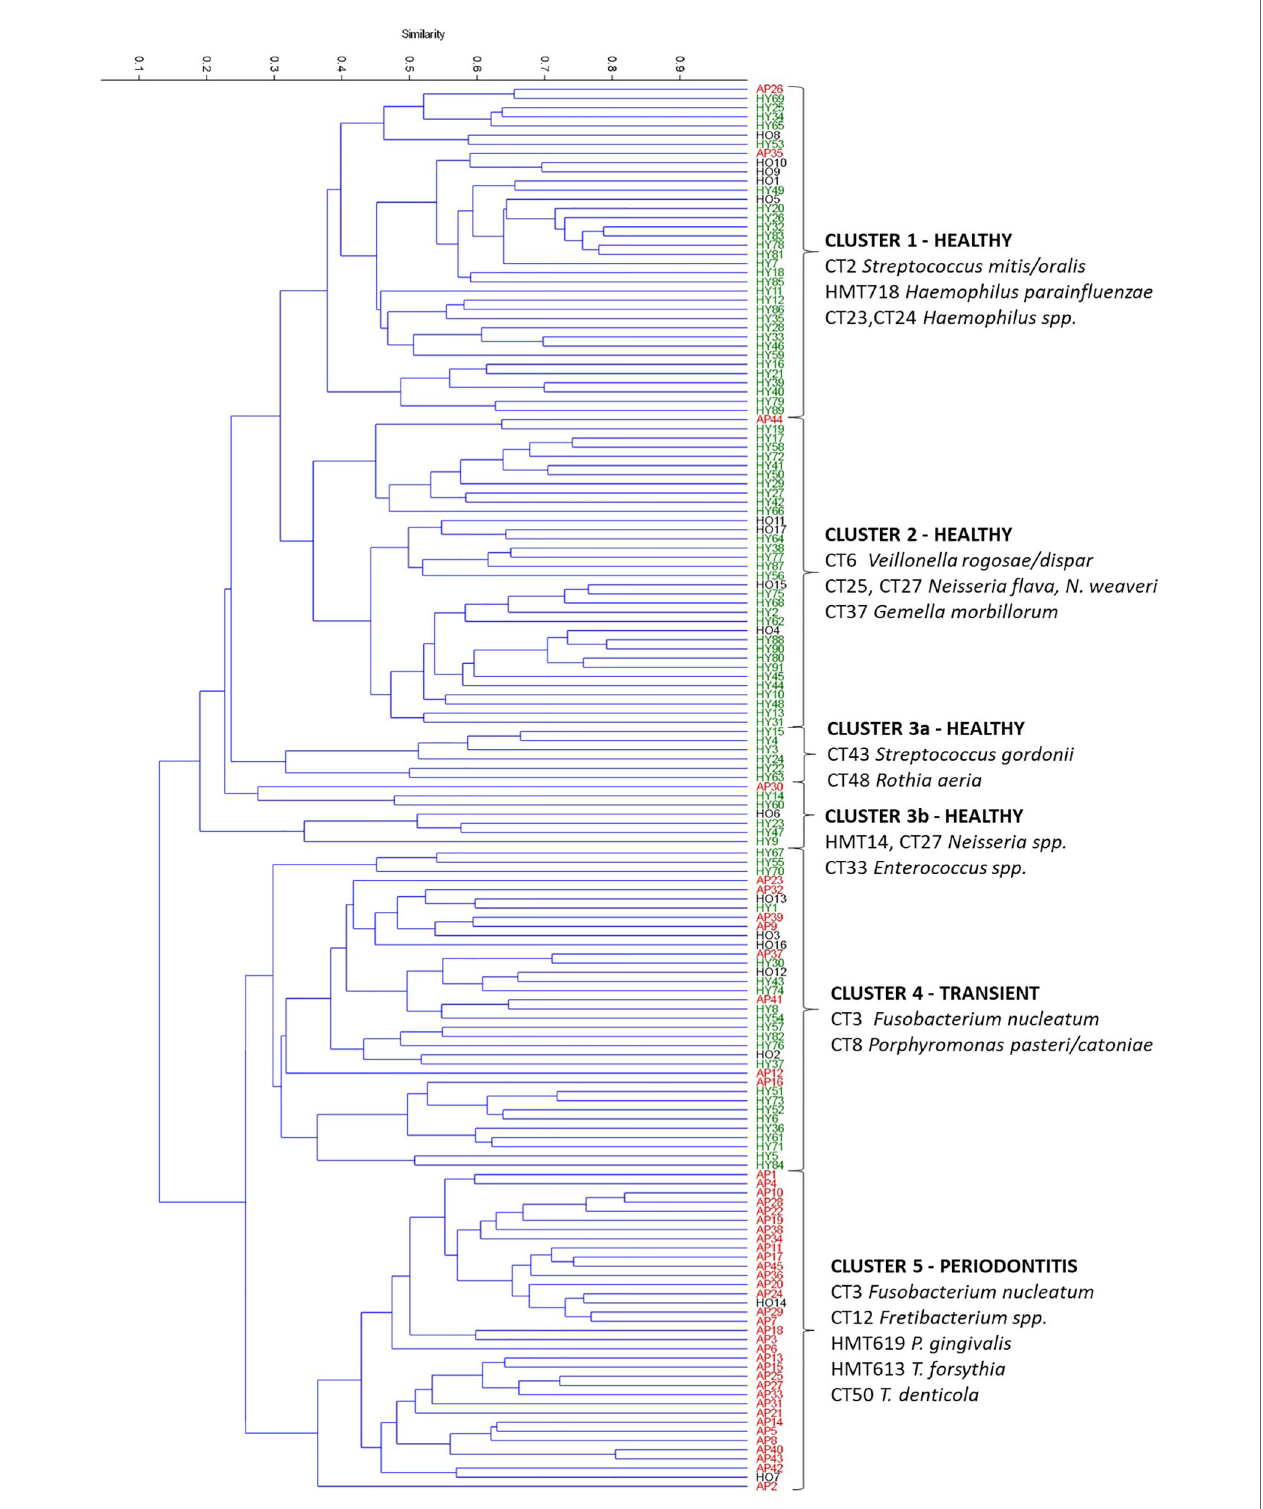
FIGURE 4 | Hierarchical clustering of all OM samples based on the Bray-Curtis similarity indexes. AP samples are marked red, HO black, and HY green. The upper measure indicates the Bray-curtis value. The determining taxa for each cluster are listed. CT stands for combined taxon (See Supplementary Table 3 ).